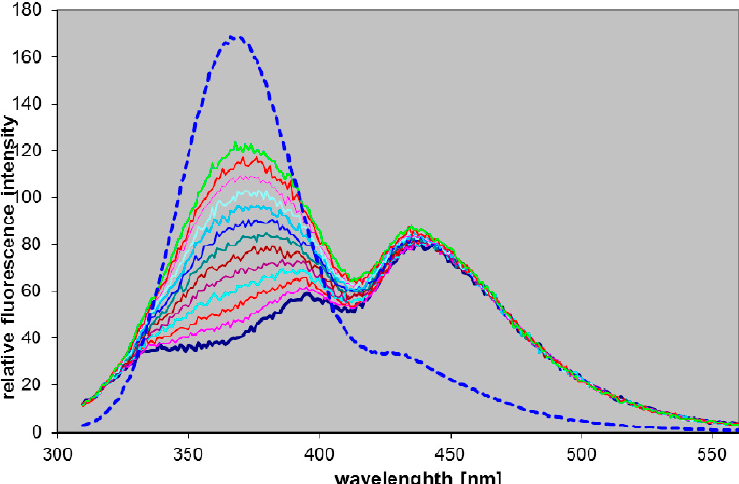
Figure 3. Fluorescence changes during the incubation of 16 µM N7-ribosyl-8-azaDaPur in 1000-diluted blood in the presence of 25 mM phosphate. Spectra, excited at 300 nm, were recorded every 5 min, and after 60 min an aliquot of the purified calf PNP was added, and fluorescence recorded after next 3 min (dotted line, 5-fold diminished relative to remaining curves). Note that the first (lowest) curve reflects blood fluorescence background, and minimum at 415 nm is due to the re-absorption by hemoglobin.